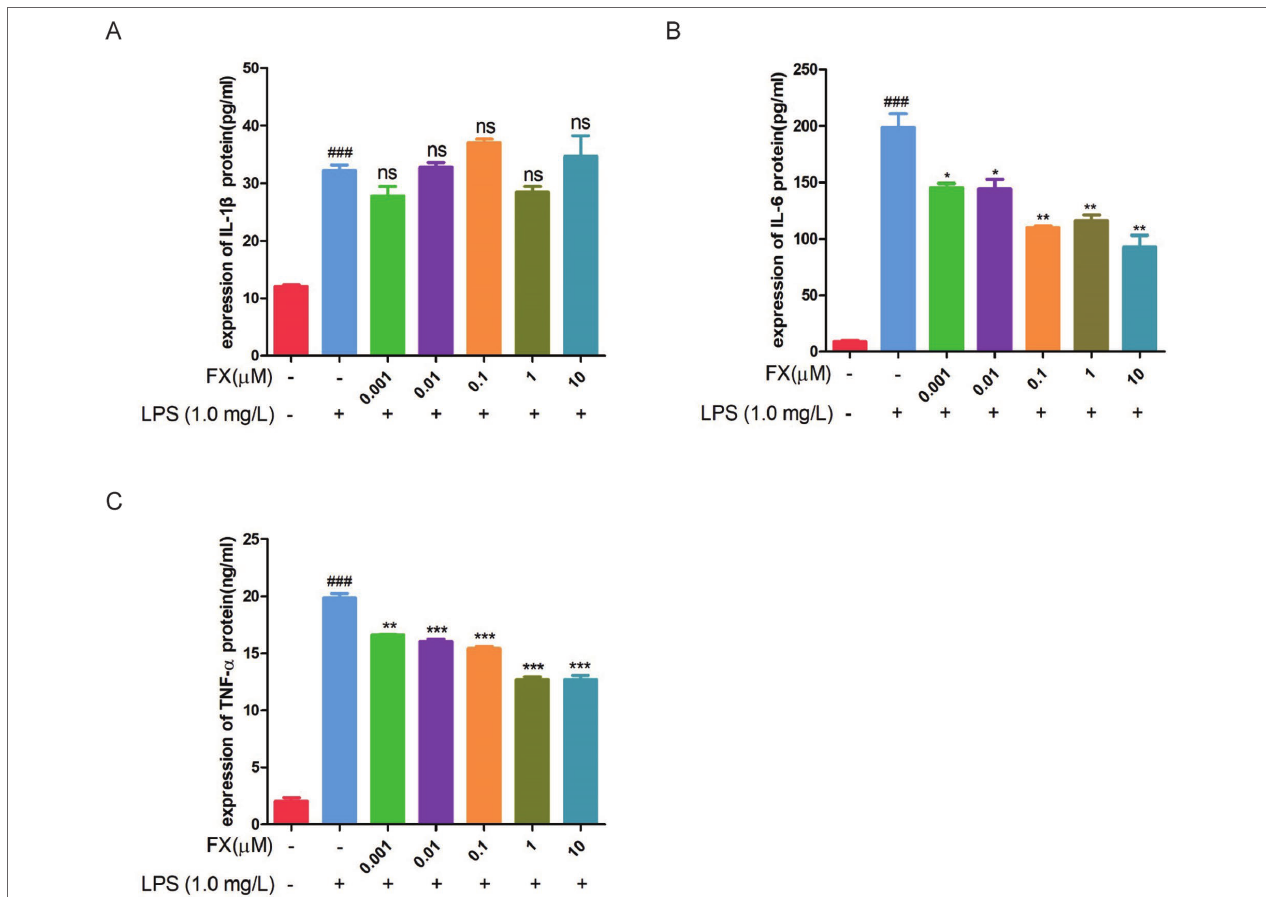
FIGURE 6 | ELISA assays were performed to test the changes in cytokine protein levels in RAW264.7 cells following FX treatment at the indicated doses or co-treatment with LPS (1.0 mg/L). (A) IL-1 β , (B) IL-6, and (C) TNF- α . The data were analyzed by the one-way ANOVA, followed by Tukey’s post hoc test. (###) p < 0.001, significantly different when compared with that of the control group. ( ∗ ) p < 0.05, ( ∗∗ ) p < 0.01 and ( ∗∗∗ ) p < 0.001, significantly different when compared with that of the LPS group, ns: not significant. The data are representative of three independent experiments